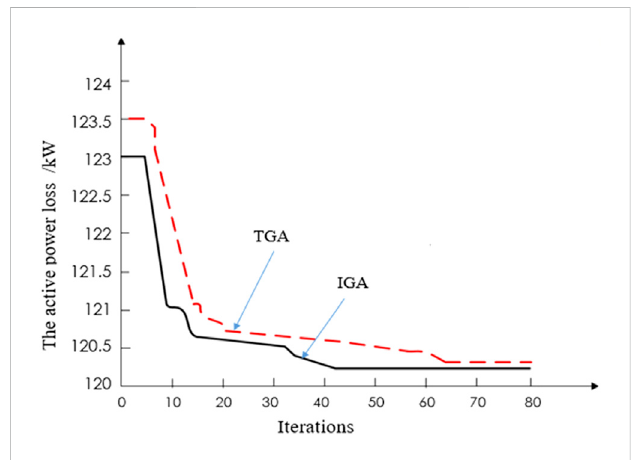
FIGURE 6 The relationship between the total active power loss and iterations when bus 12 is compensated.